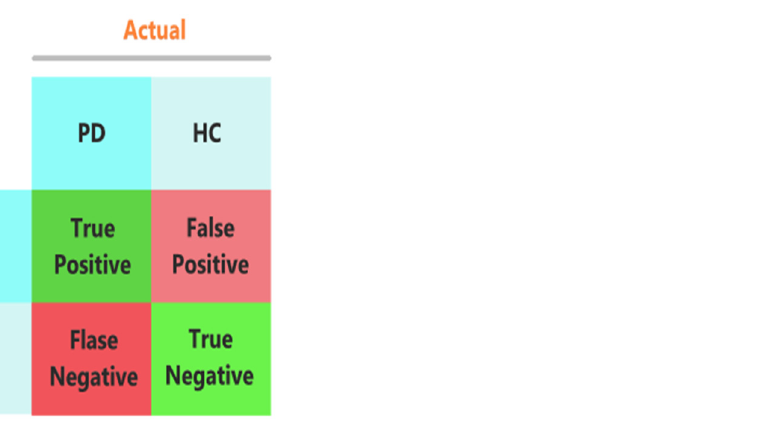
Figure 4. The confusion matrix: TP, TN, FP, and FN.